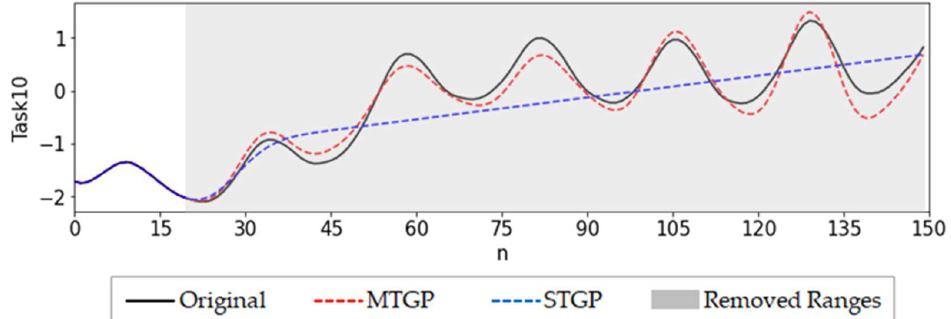
Figure 15. Imputation results of MTGP and STGP for the extreme situation (with data pre-processing).